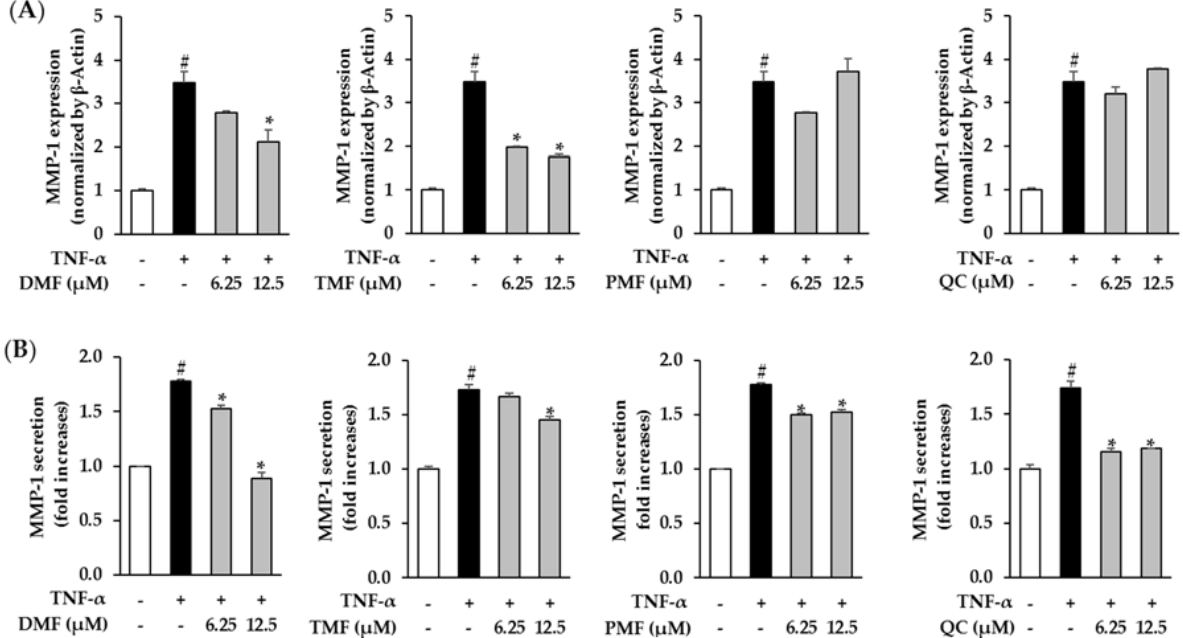
Figure 4. Effects of DMF, TMF, PMF, and QC (positive control) on MMP-1 mRNA expression ( A ) and secretion ( B ). HDFs were plated at a density of 2 × 10 4 cells/well in a 48-well plate and starved with serum-free media for 24 h. Next, the cells were treated with specific concentrations of the samples for 1 h before exposure to 20 ng/mL TNF- α for 24 h. The MMP-1 mRNA level was assessed using qRT-PCR analysis. MMP-1 secretion in the cell supernatants was determined using an ELISA kit. The data were expressed as mean ± standard error of mean (SEM) ( n = 2). # p < 0.05 compared to non-treated group and * p < 0.05 compared to TNF- α -treated group. Abbreviations: DMF, 5,7-dimethoxyflavone; TMF, 5,7,4 (cid:48) -trimethoxyflavone; PMF, 3,5,7,3 (cid:48) ,4 (cid:48) -pentamethoxyflavone; and QC,